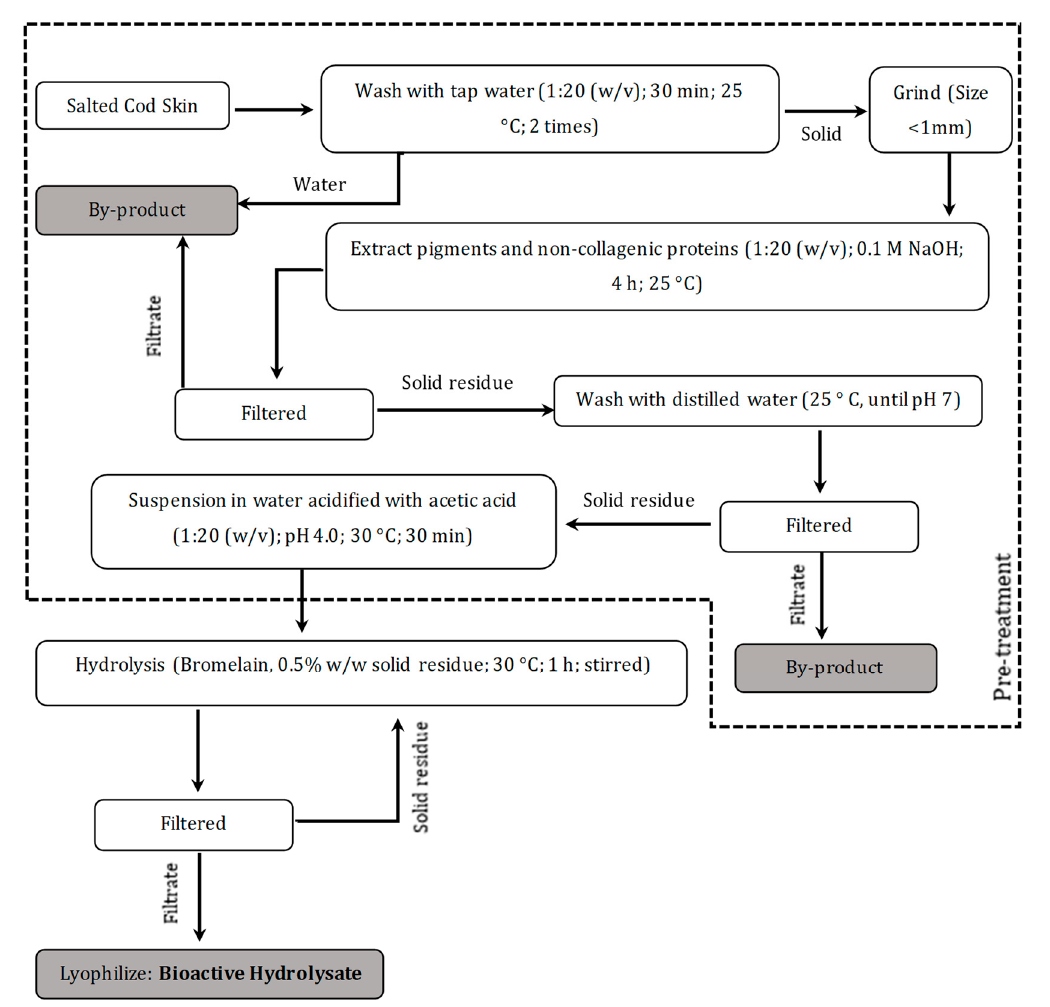
Scheme 1. Optimised process. Flow diagram of the optimal process proposed to produce the bioactive hydrolysates from